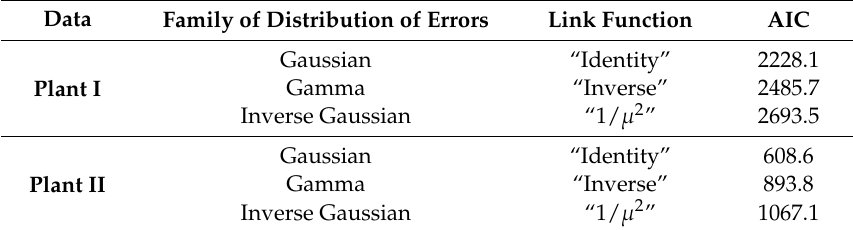
Table 5. AIC values for candidate